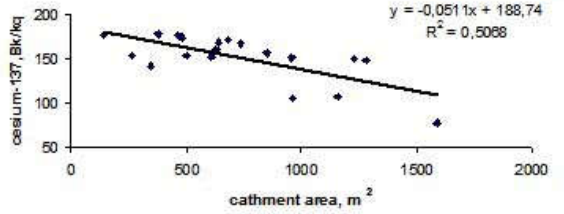
Figure 8 . Dependence of the caesium-137 specific activity on catchment area value in zone